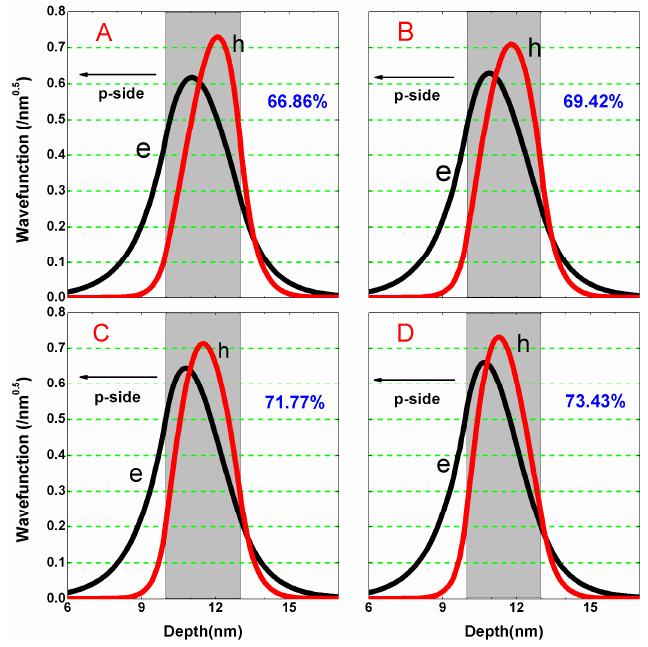
Figure 6. The wavefunctions of electrons (e) and holes (h) in the last QW for samples A , B , C and D